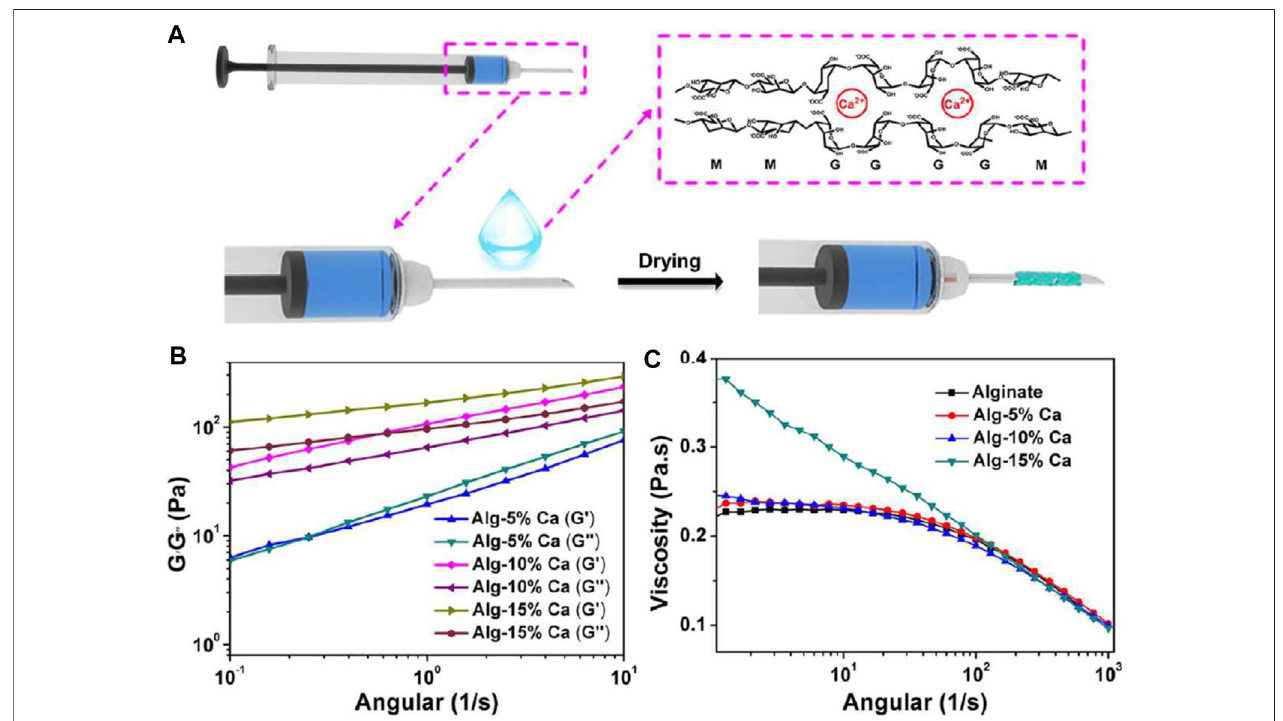
FIGURE 4 | Preparation of the hemostatic needles with the Alg-Ca coatings. (A) Schematic illustration of the preparation of hemostatic hydrogel coatings on syringe needles. (B) Rheological analysis of Alg-5% Ca, Alg-10% Ca, and Alg-15% Ca hydrogel fi lms after exposure to serum. (C) The viscosity of alginate, Alg-5% Ca, Alg-10% Ca, and Alg-15% Ca precursor solutions. Reproduced from (Ren et al., 2020) with permission from Copyright 2020 Elsevier.